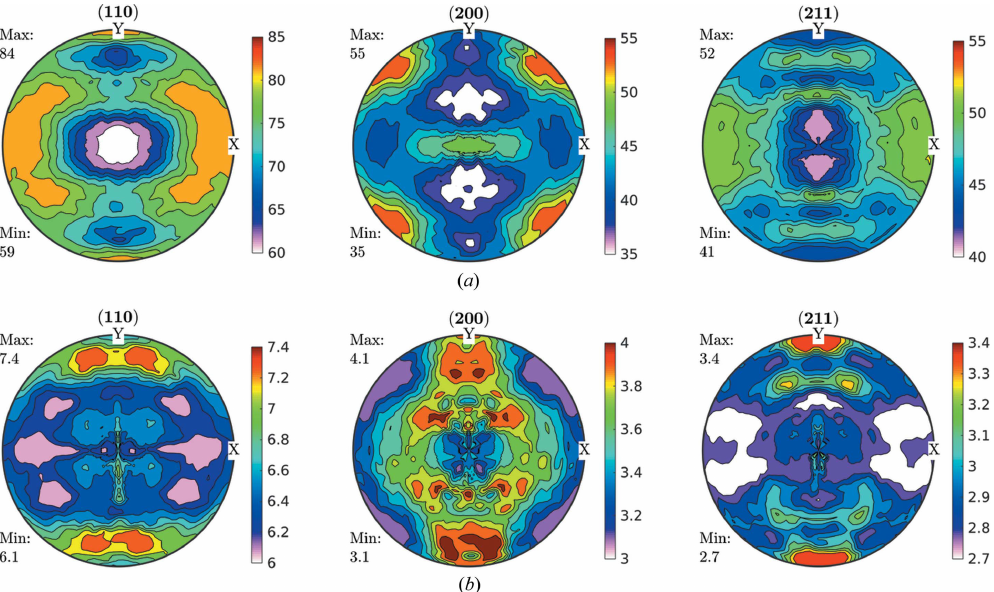
Figure 7 GPFs for ( a ) domain size (nm) and ( b ) dislocation density ( (cid:4) 10 14 m (cid:3) 2 ), as separated by following the Langford model from FWHM GPFs for the IF cold-rolled sample.